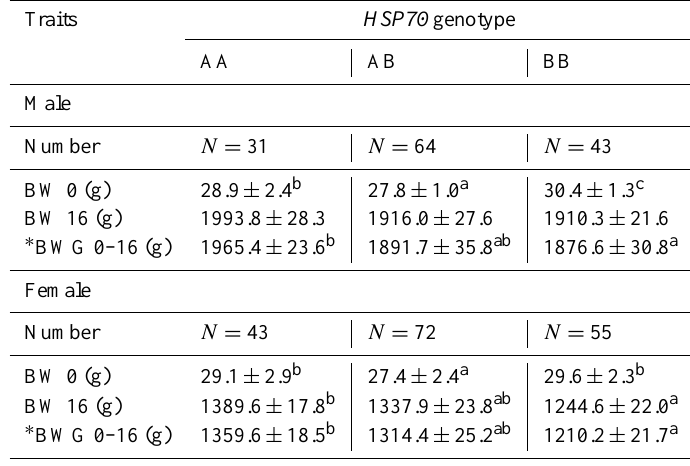
Mean ± SE. BW 0: body weight at hatching; BW 16: body weight at 16 weeks of age; BWG 0–16: body weight gain from 0 to 16 weeks of age. a,b,c Means within a row lacking a common